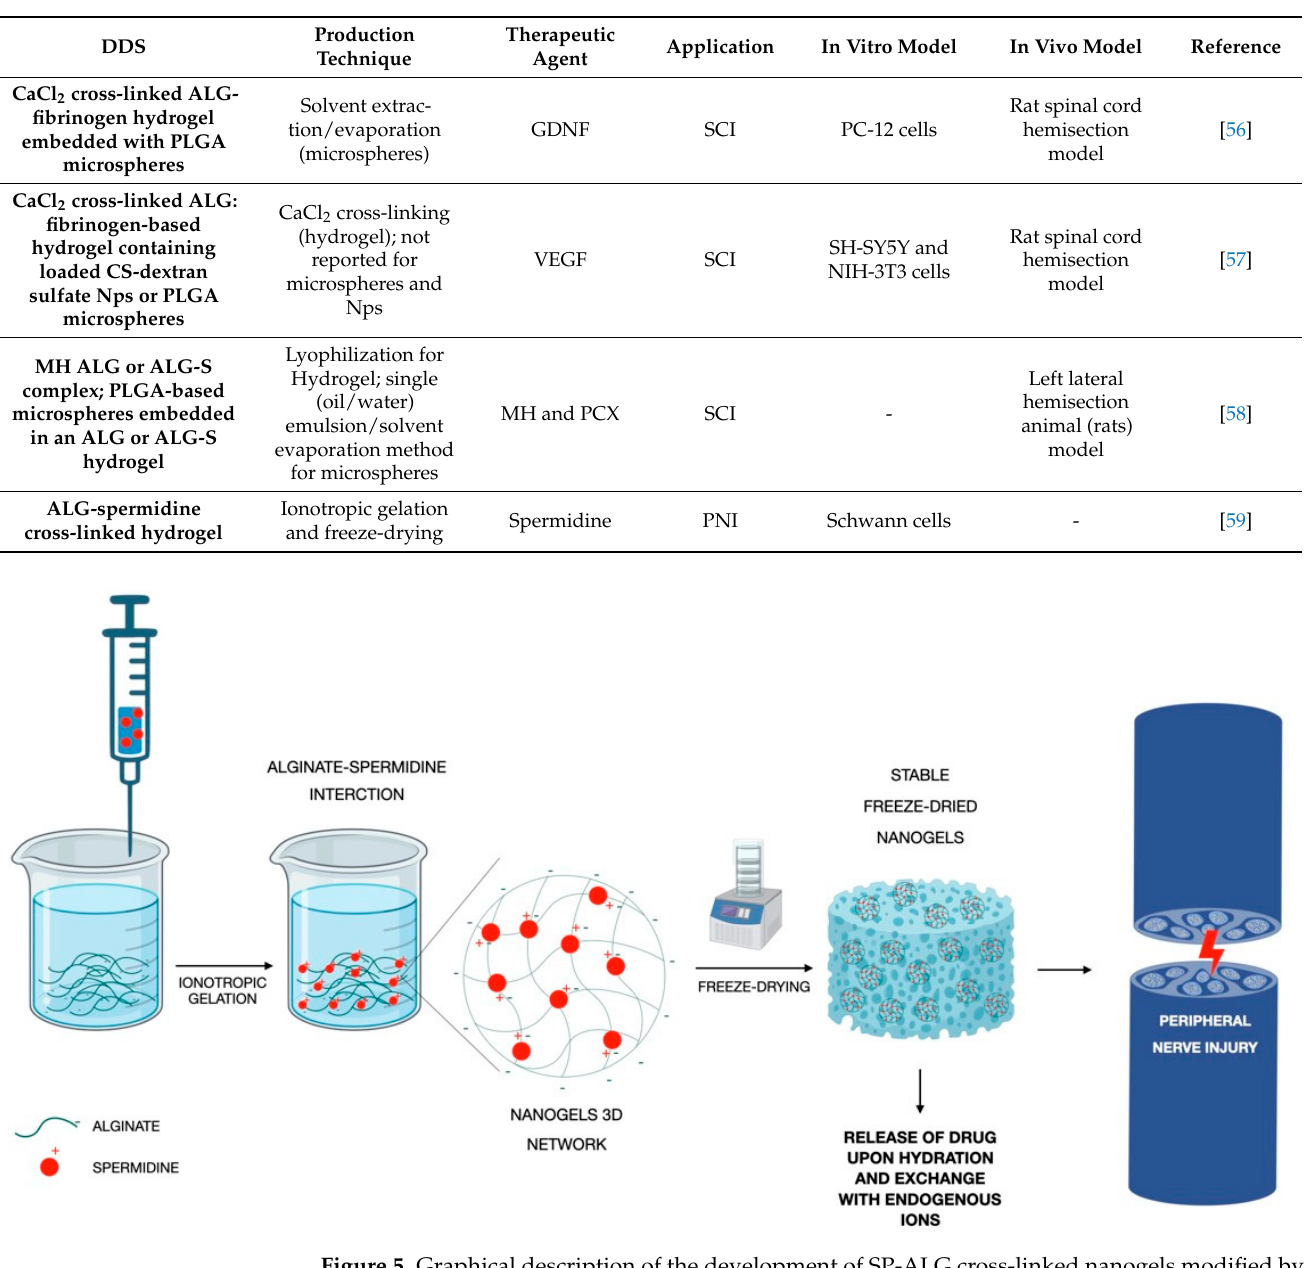
Table 2. Summary of ALG-based DDSs for SCI and PNI application. DDS description, production technique, therapeutic agent delivered, in vitro and in vivo models exploited for efficacy assessment are reported.